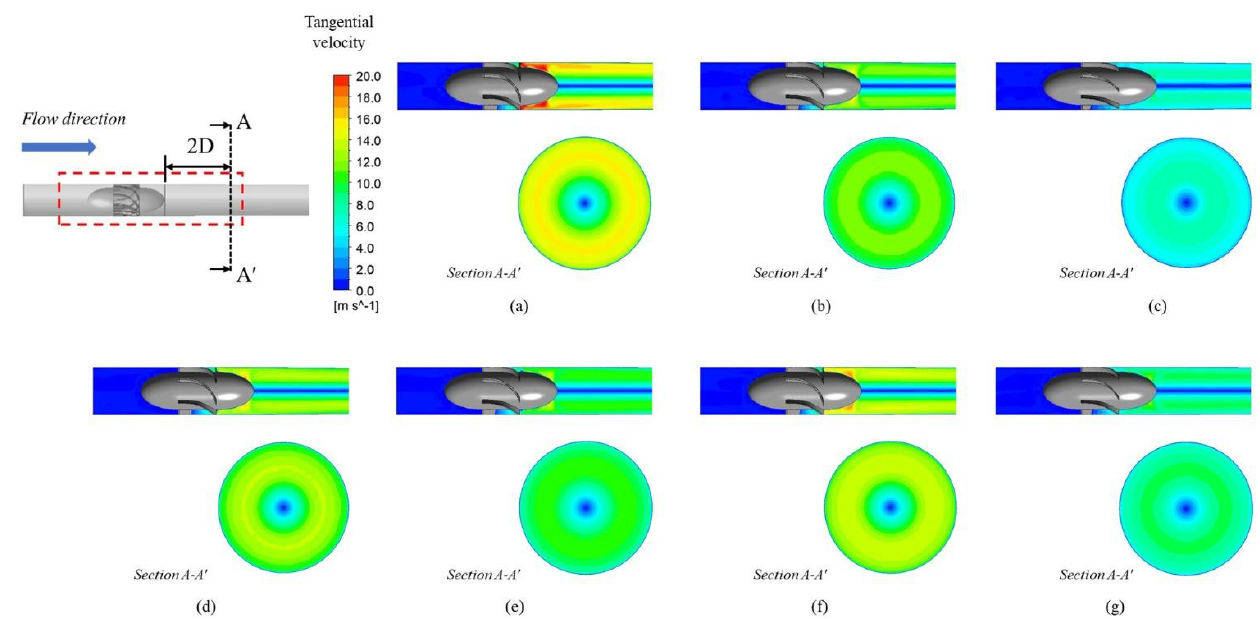
Figure 7. Distribution of tangential velocity at six vanes: Design point 5 ( a ), 15 ( b ), 17 ( c ), 20 ( d ), 21 ( e ), 25 ( f ), 28 ( g ).